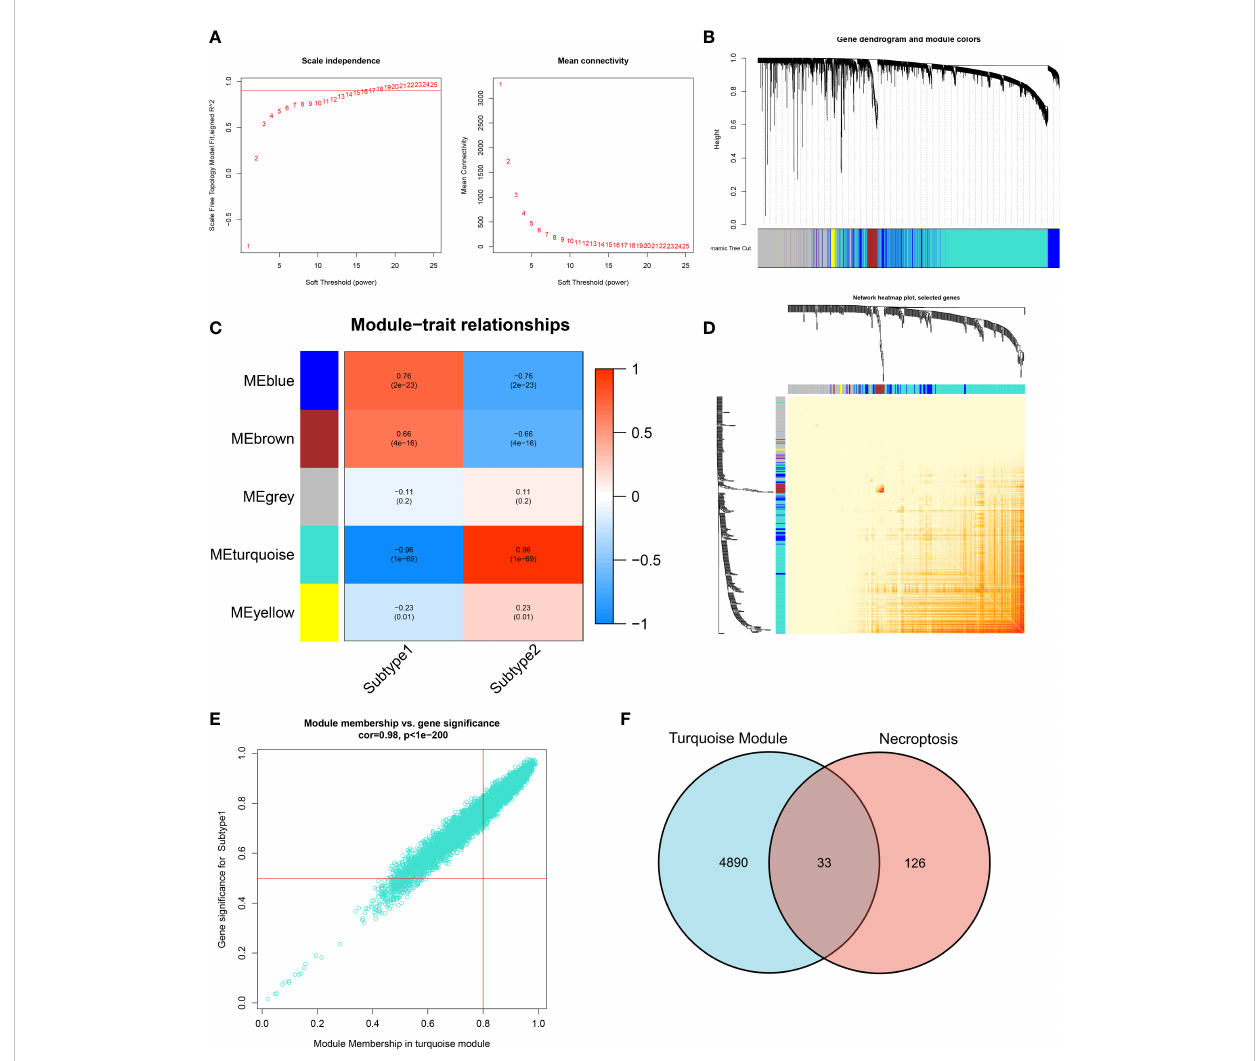
FIGURE 8 Identi fi cation of necroptosis-related NRGs base on WGCNA algorithm. (A) Analysis of scale-free fi tting index and average connectivity for multiple soft-threshold parameters. (B) Representative hierarchical clustering of genes based on the different topological overlaps and module colors. (C) Representative module-trait heatmap revealing the correlation of the module eigenvalues with distinct subtypes. (D) Representative heatmap of gene networks. (E) Representative scatter plot revealing the correlation between turquoise modules and module membership. (F) Representative Venn diagram revealing the intersection of turquoise module-related genes and obtained